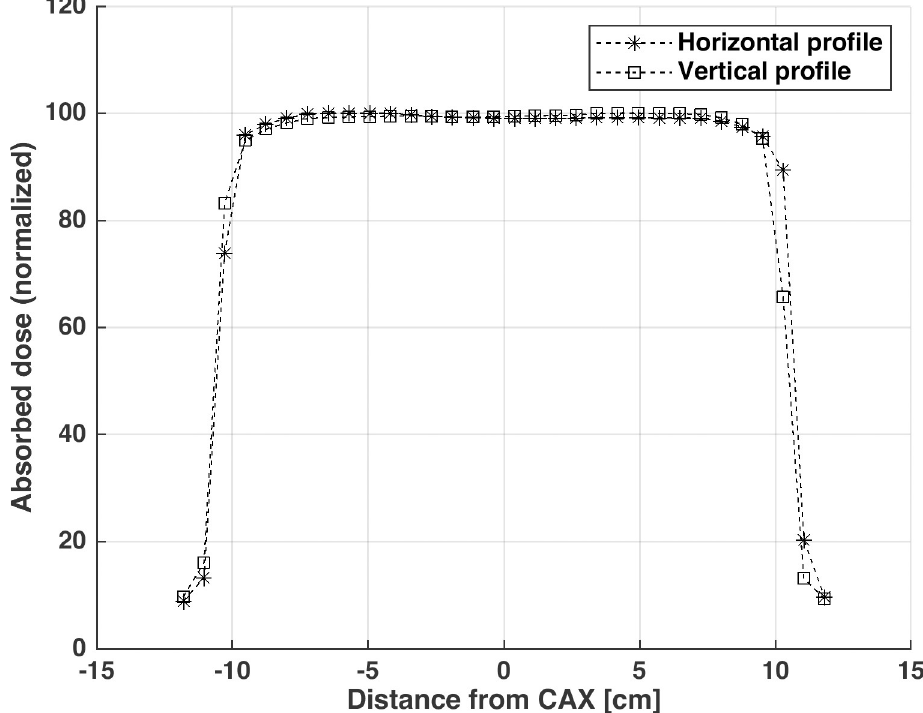
Fig 7. 20.0 × 20.0 cm 2 open field measured by an ion chamber array at the depth of 5.0 cm in the water phantom with an SSD of 100.0